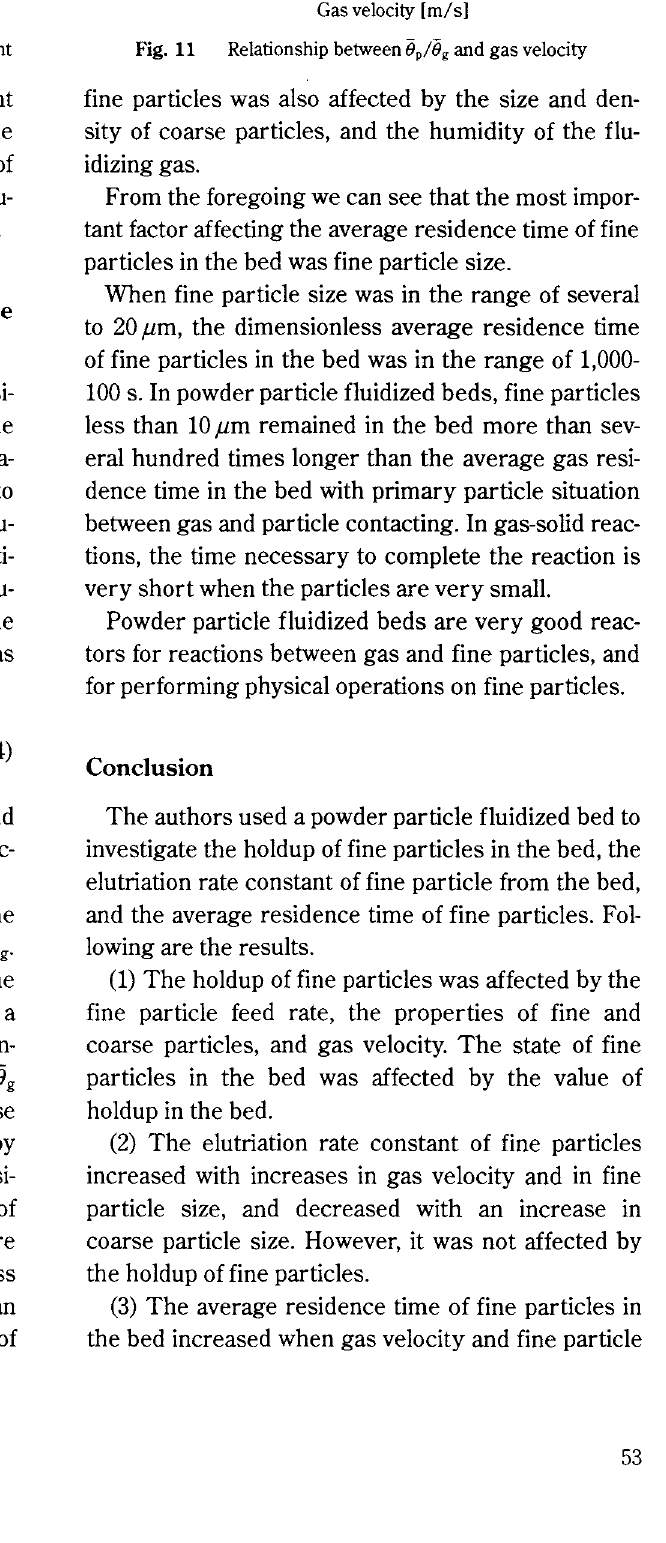
Relationship between Op/Og and gas